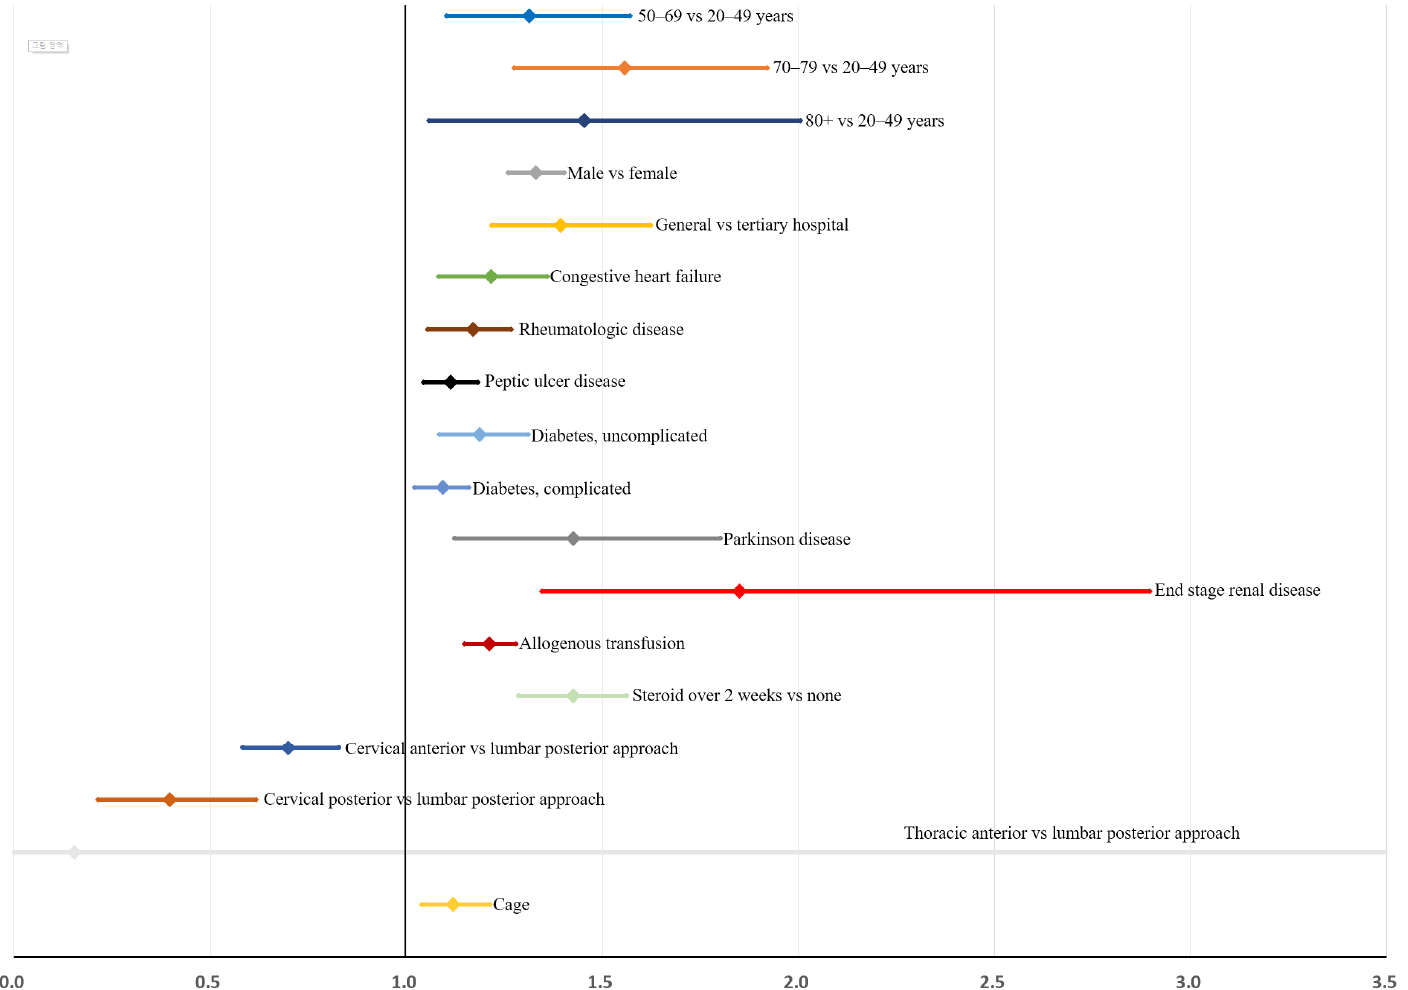
Figure 5. Risk factors for reoperation within 1 year after instrumented spinal fusion surgery for degenerative spinal disease: bootstrap ‐ adjusted odds ratios and their 95% confidence interval (Supplementary Table S4).